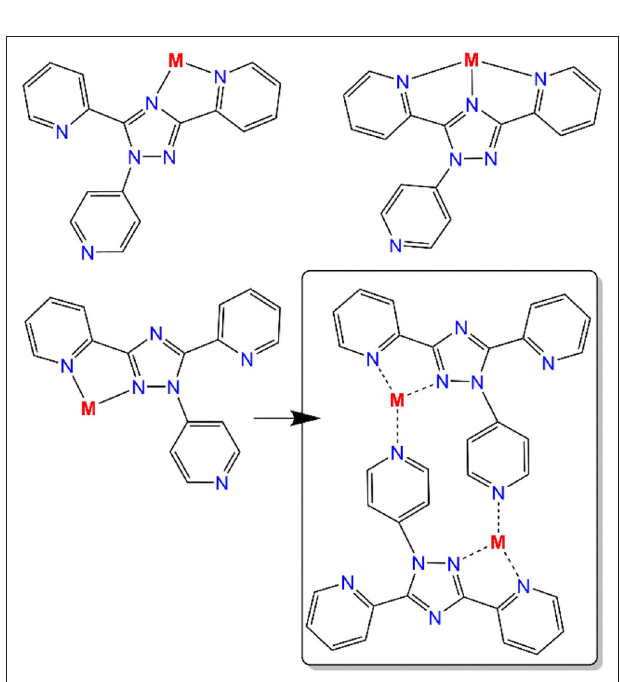
( Figure 2 ), with the N 4 substituted compound, 4-pyridyl-3,5-di- 2pyridyl-4H-1,2,4-triazole ( N 4 - pydpt ) being the kinetic and N 1 ( N 1 - pydpt ) the thermodynamic products (Kitchen et al., 2010b). Whilst N 4 - pydpt has the same variety of binding modes as other Rdpt systems, for the rearranged N 1 -pydpt system a range of alternative binding modes can be anticipated ( Figure 3 )—whilst the N 1 N 2 -triazole bridging mode is precluded.